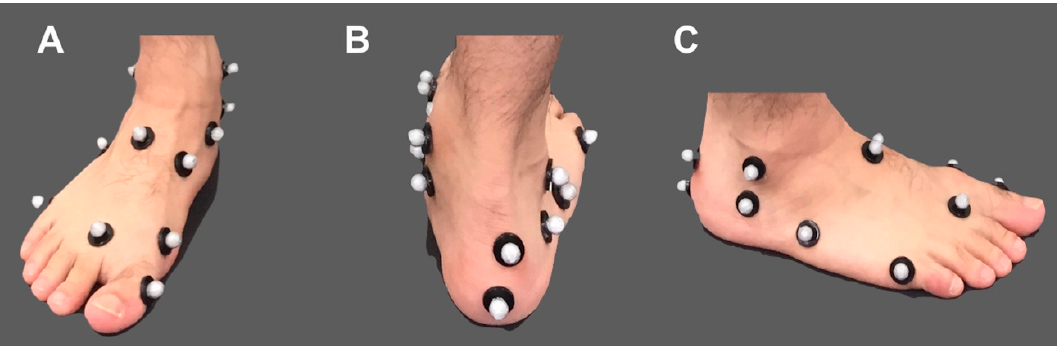
Figure 4. The right foot which attached the infrared-reflection markers, shown from the front ( A ), from the back ( B ), and from the outside ( C